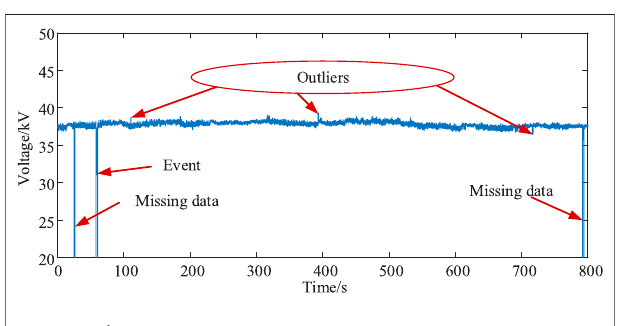
FIGURE 9 | A feature of real-world PMU data.